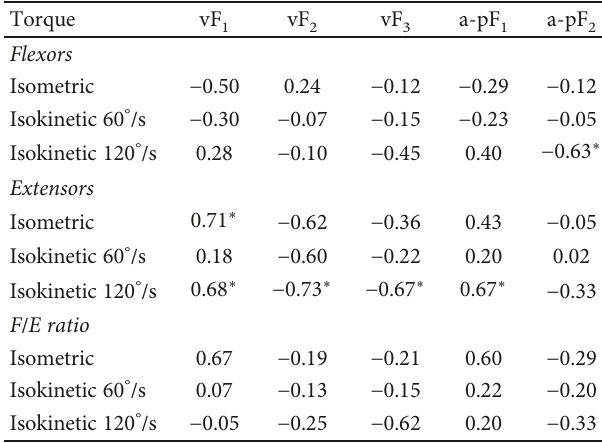
Table 2: Vertical (v), anterio-posterior (a-p) GRF, and muscle torque of hip fl exor and extensor variables and symmetry indexes between sides. Statistically signi fi cant di ff erences between the sides are marked with an